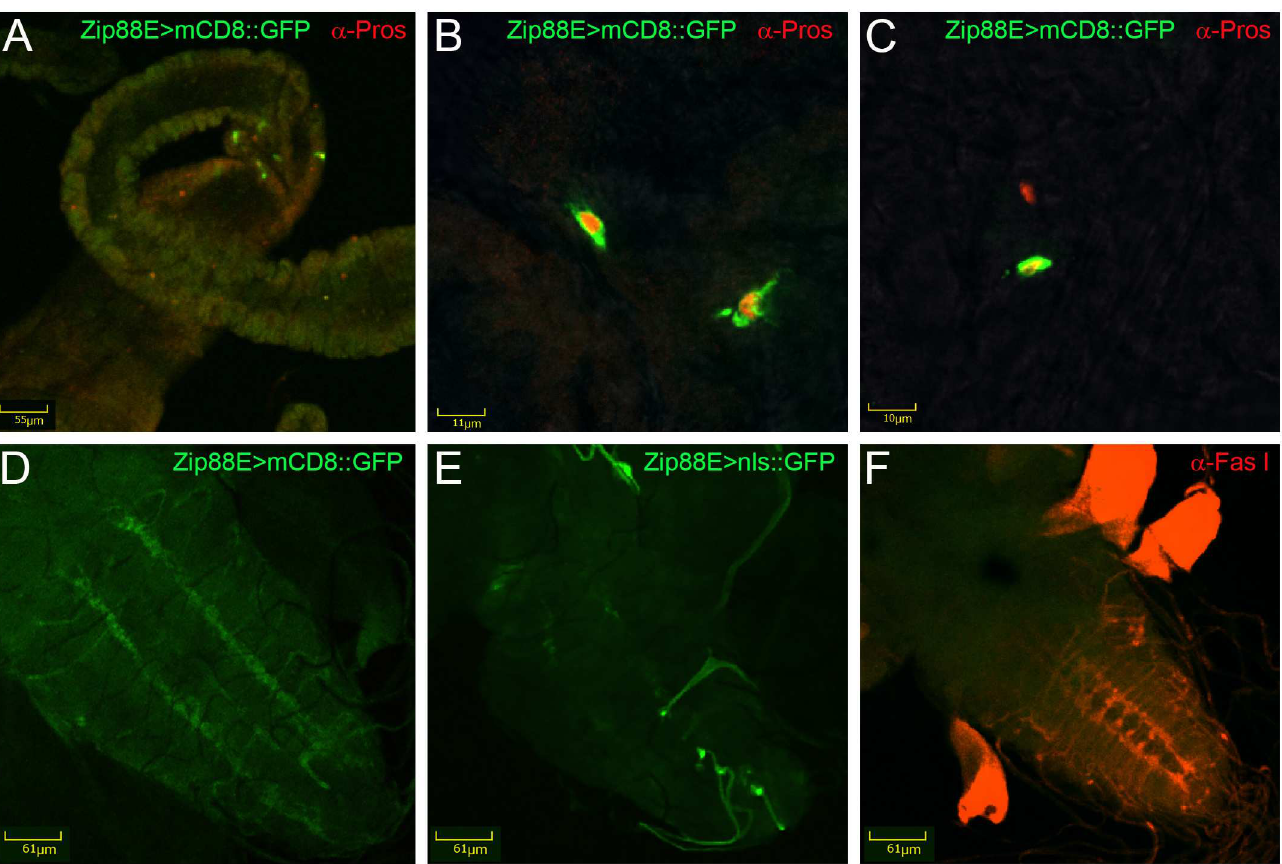
Fig 5. Cells expressing the Zip88E reporter gene are enteroendocrine cells. Confocalmicroscopy of midguts (A-C) and CNS (D-F) of third instar larvae. A-C) Low (A) and high (B, C) magnification images of larval midguts showingZip88E > mCD8::GFP (green)and α -Prospero(red). While all GFP +ve cells also show nuclear α -Prosperostaining,indicatingthey are enteroendocrine cells, numerousother α -Prospero+ve cells in the same midgut regionshow no GFP signal. D-F) Larval CNS showingZip88E > mCD8::GFP (D), Zip88E > nls::GFP (E) and α -FasciclinI (F, red). The GFP positive axons highlighted by the Zip88E reporter gene do not have cell bodieswithin the CNS and do not appearto lie in the same regionas the Fasciclin I +ve axons.